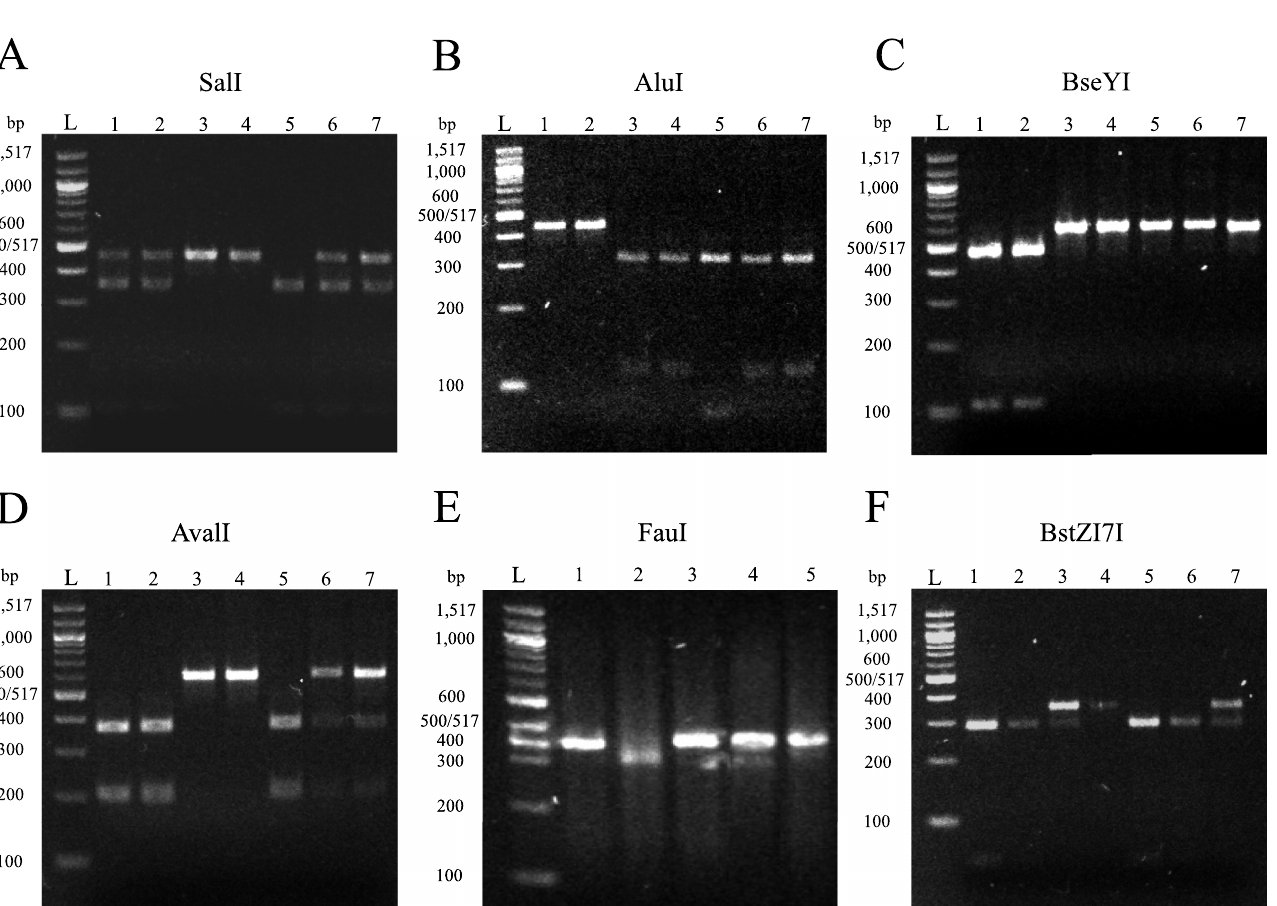
Fig 2. Electrophoresis pattern of the PCR-RFLP. Panel A: diacylglycerol acyltransferase (TcCLB.507467.90) digested with SalI. Panel B: diacylglycerol acyltransferase (TcCLB.507467.90) digested with AluI. Panel C: ccr4-not transcription complex subunit (Tc00.1047053510535.60) digested with BseYI. Panel D: ccr4-not transcription complex subunit (Tc00.1047053510535.60) digested with AvalI. Panel E: amino acid permease-like protein (Tc00.1047053510251.10) digested with FauI. Panel F: amino acid permease-like protein (Tc00.1047053510251.10) digested with BstZ17l. Lane numbers for panels A-D and F: (1) strain EV-13C (DTU I); (2) strain CA-1-05 (DTU I); (3) strain CBBcl3 (DTU II); (4) strain ESMcl3Z2 (DTU II); (5) strain CANIII (DTU IV); (6) strain PSC-O (DTU V); (7) strain Tulacl2 (DTU VI). Lane numbers for panel E: (1) strain Ev13C (DTU I); (2) strain ESMcl3Z2 (DTU II); (3) strain CANIII (DTU IV); (4) strain PSC-O (DTU V); (5) strain Tula cl2 (DTU VI). DNA ladder (L) (NEBioLabs,